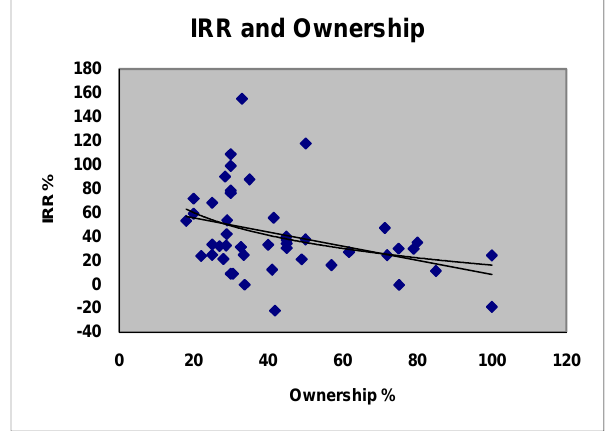
Figure 1: IRR and ownership scatter